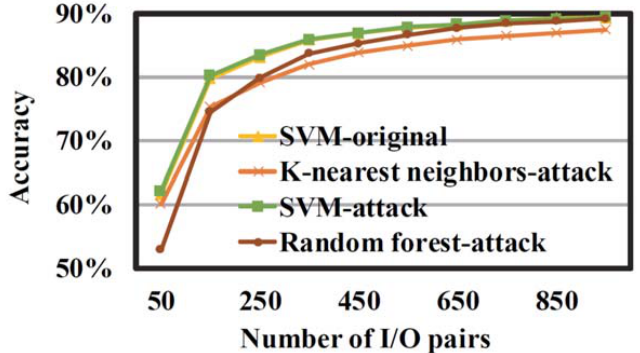
Figure 56. Comparison of learning accuracy among the original model and other learning models.